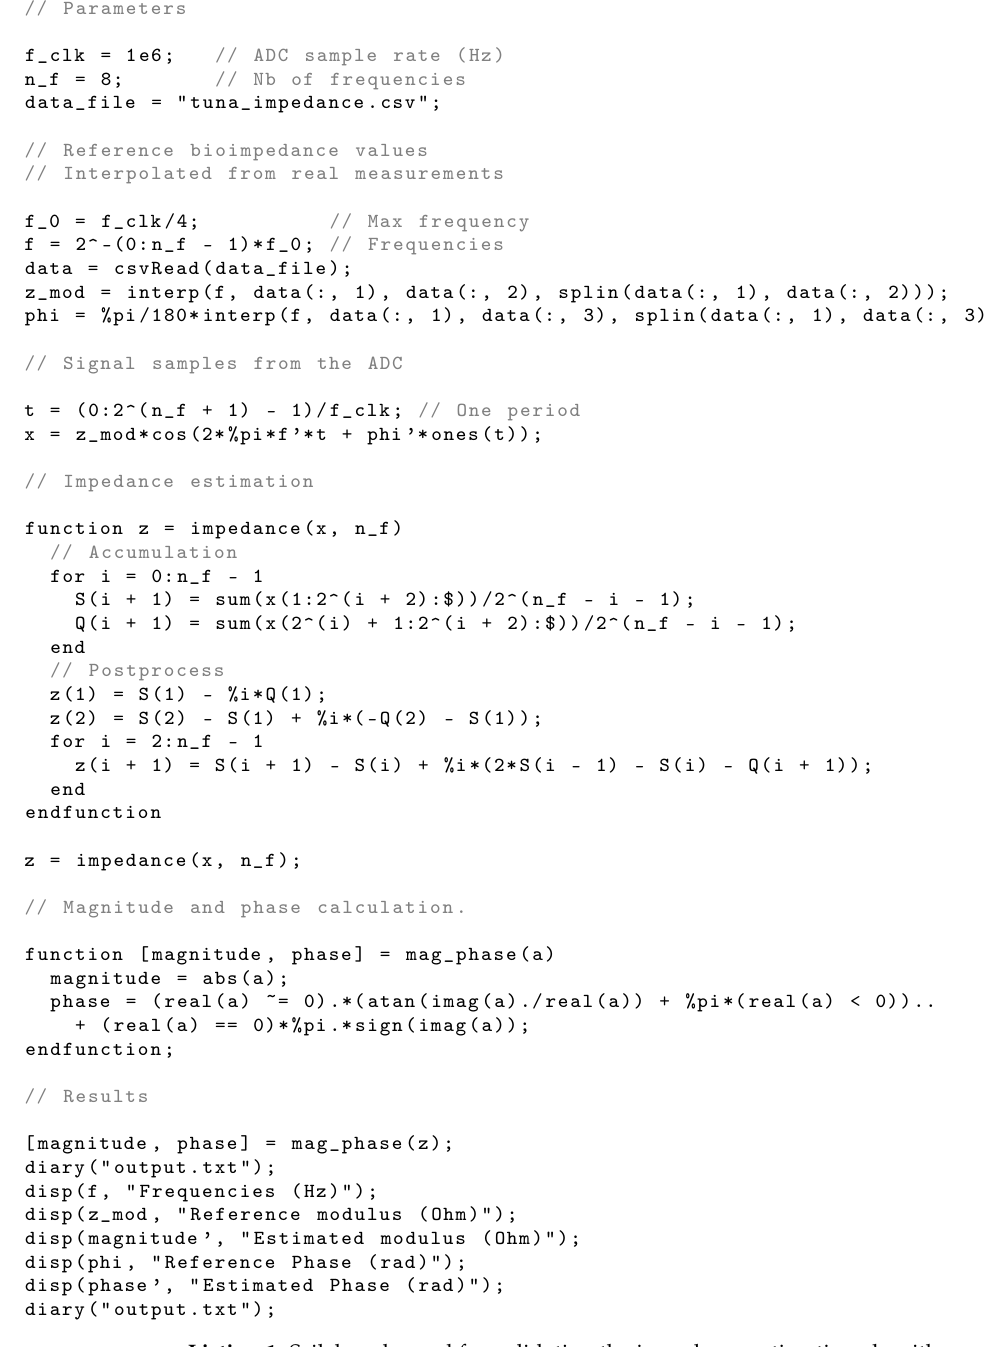
Listing 1. Scilab code used for validating the impedance estimation